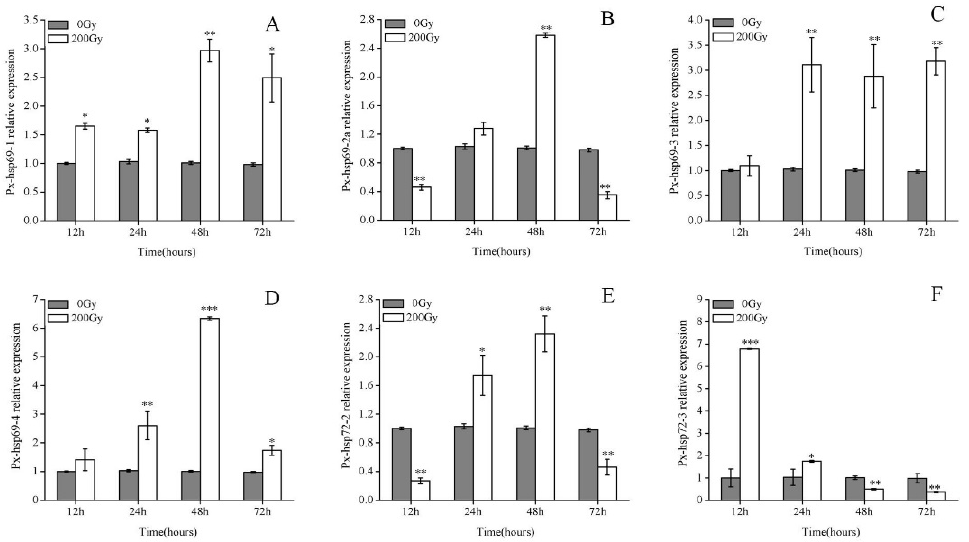
Figure 2. Effect of 60 Co- γ radiation stress on the expression of ( A ) Px-hsp69-1, ( B ) Px-hsp69-2a, ( C ) Px-hsp69-3, ( D ) Px-hsp69-4, ( E ) Px-hsp72-2, ( F ) Px-hsp72-3 in DBM pupae. Values are the mean ± SD ( n = 3). Asterisk designates statistically significant difference between control and irradiated pupae (*** p < 0.001; ** p < 0.01; * p < 0.05).